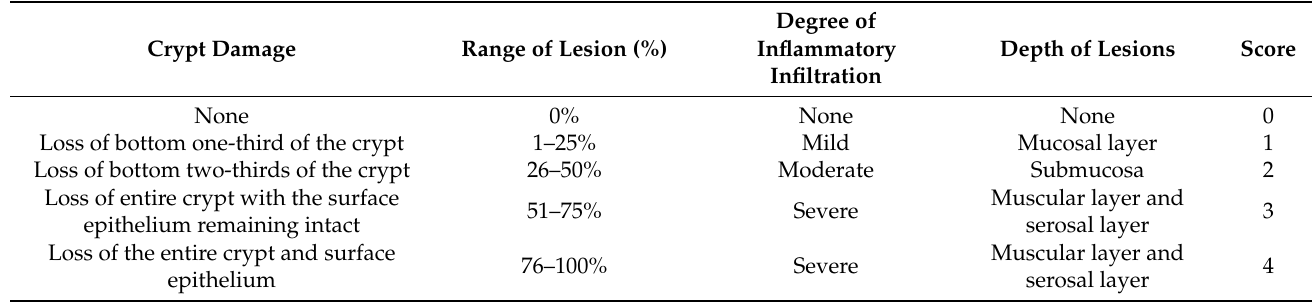
Table 2. Histological score.